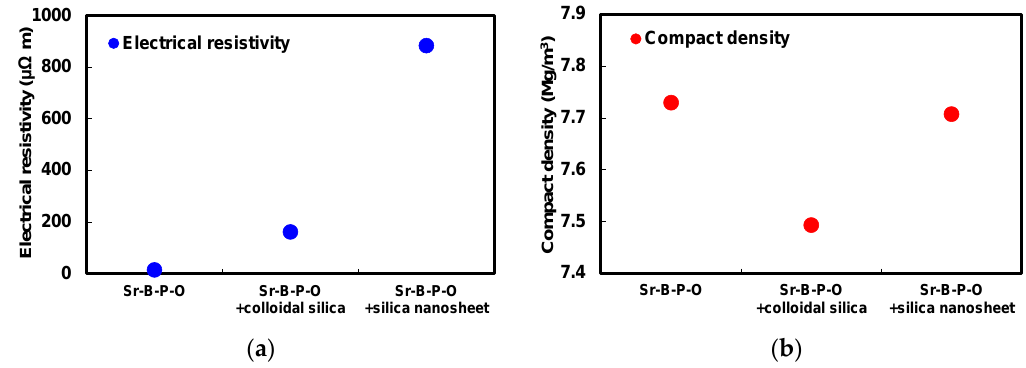
Figure 6. ( a ) Electrical resistivities; and ( b ) compact densities of annealed toroidal cores fabricated from iron powder particles coated only with Sr-B-P-O insulating layers, and with five coatings of colloidal silica or silica nanosheets over Sr-B-P-O insulating layers.